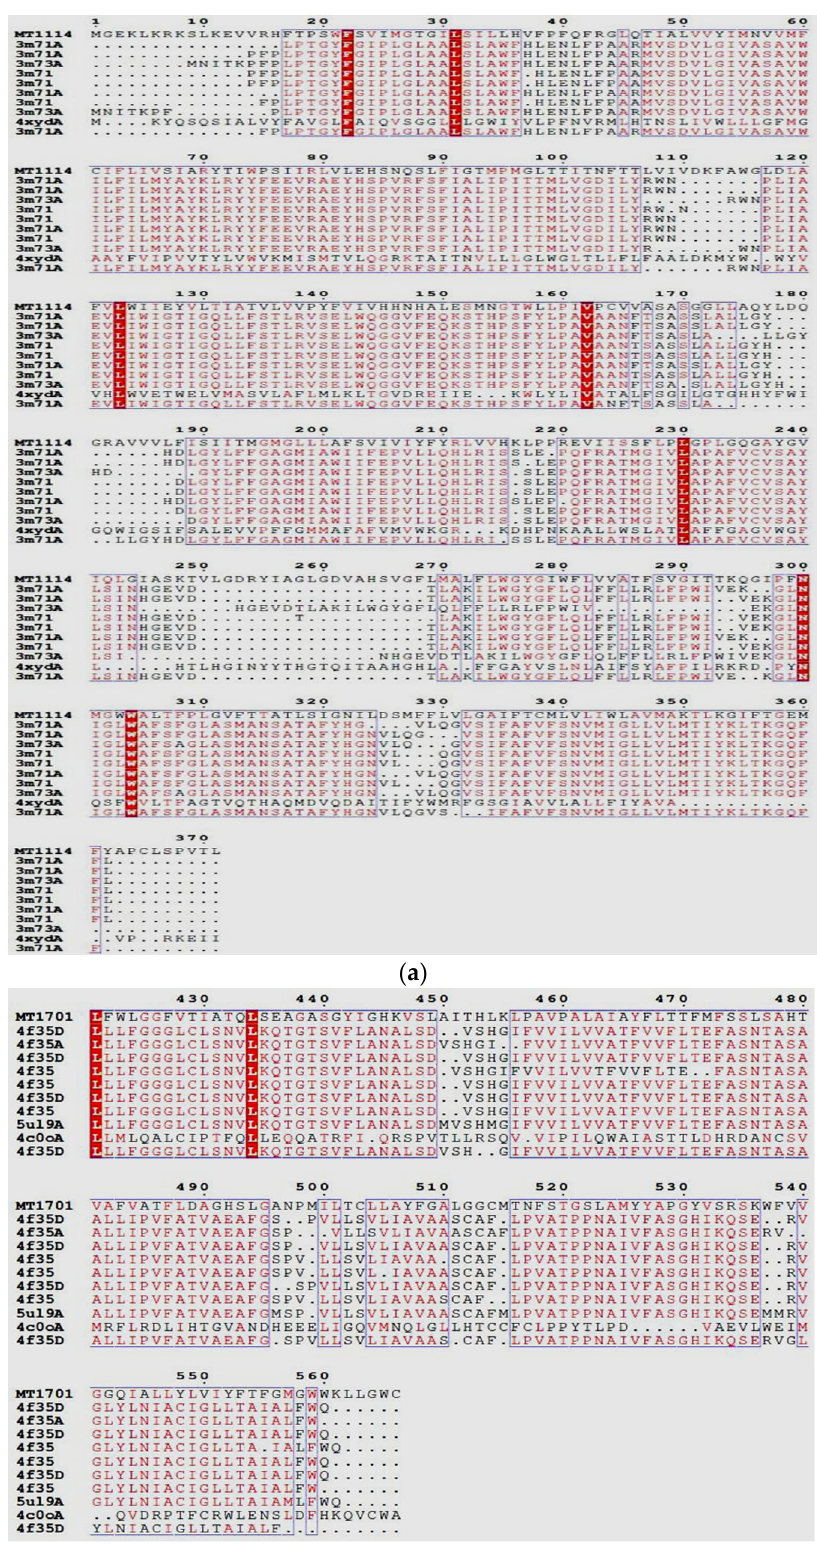
Figure 1. Multiple sequence alignment of ( a ) MT with an accession number KQ435319.1 and ( b ) SoDIT-a protein with an accession number KQ435538.1. Blue boxes indicate similar regions, red sequences within the boxes indicate sequences that are consistent with the comparison results, and red underlining indicates conserved loci.